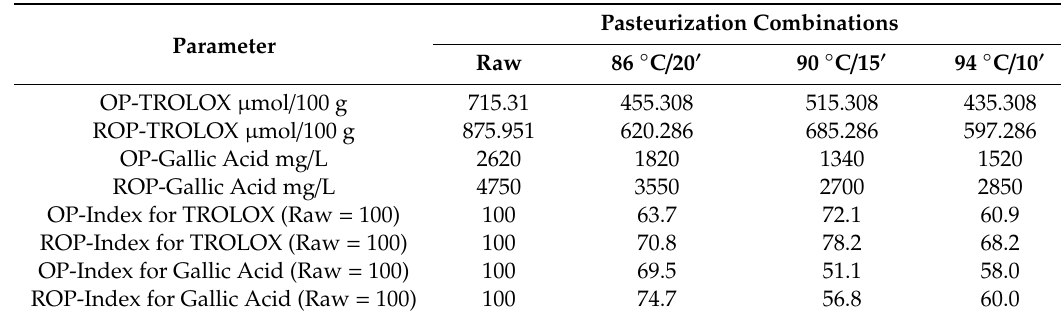
Table 4. Antioxidant activities after pasteurization under different t/t combinations